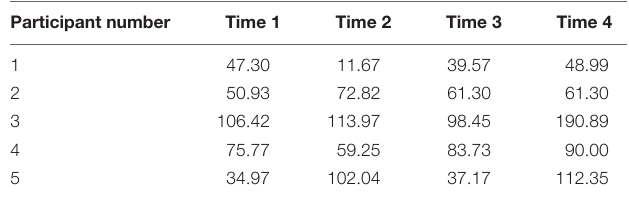
baseline to final (and any improvement in individual number of participants)